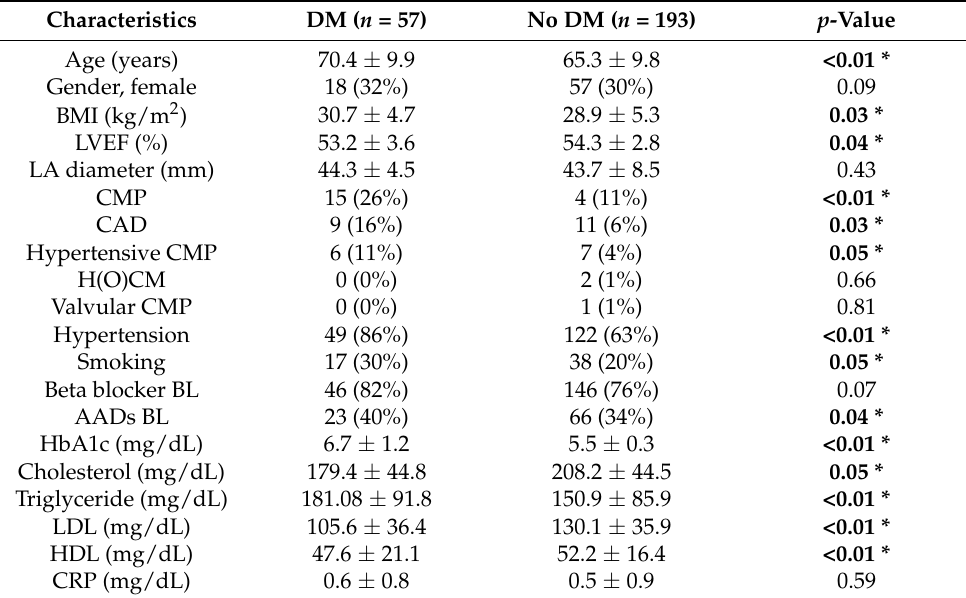
Table 3. Baseline Characteristics in PERS depending on